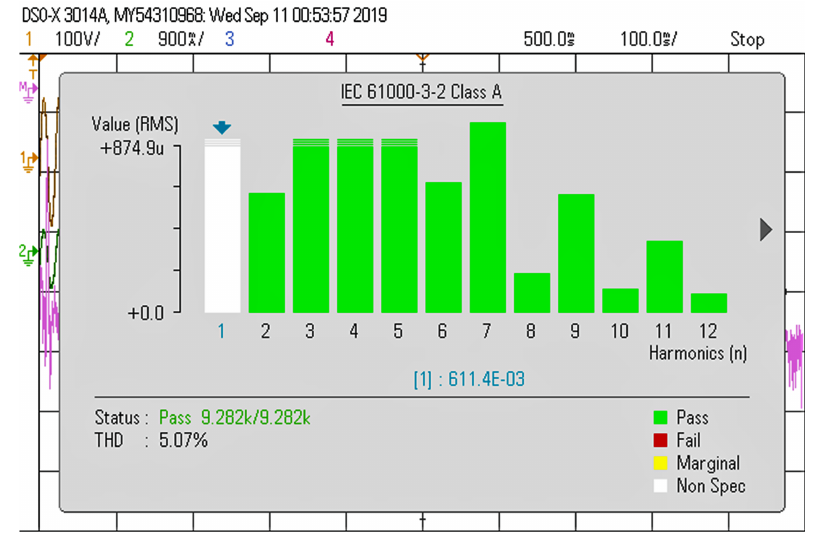
Figure 21. THD of injected current at P max = 70